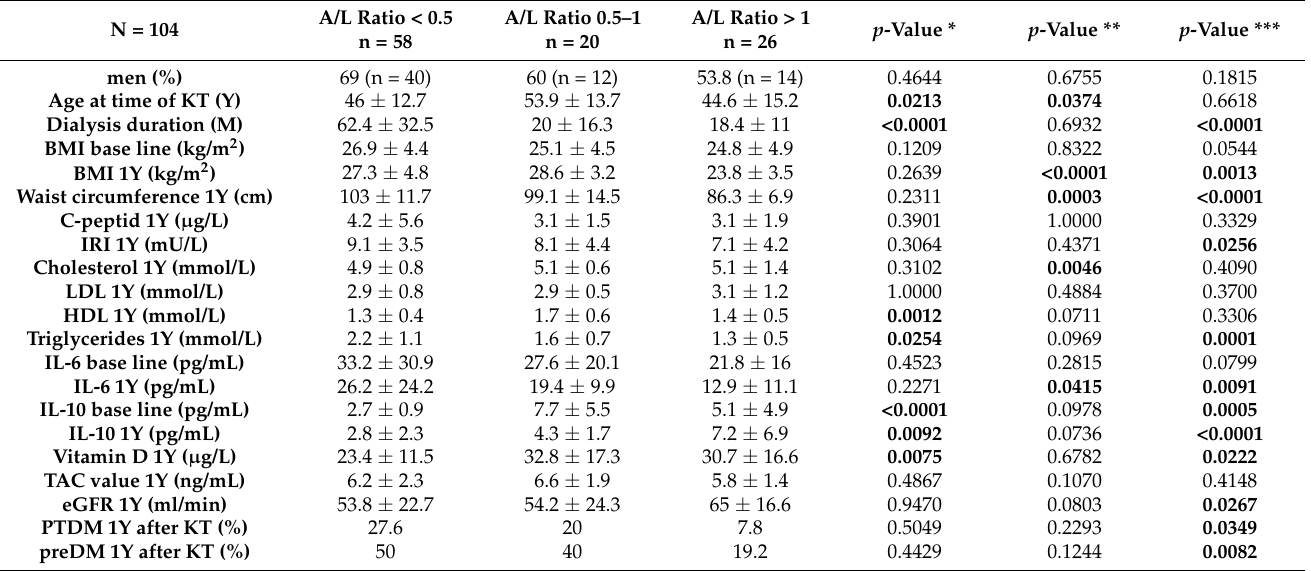
Table 2. Comparison of the observed group according to A/L ratio in one year after kidney transplantation.